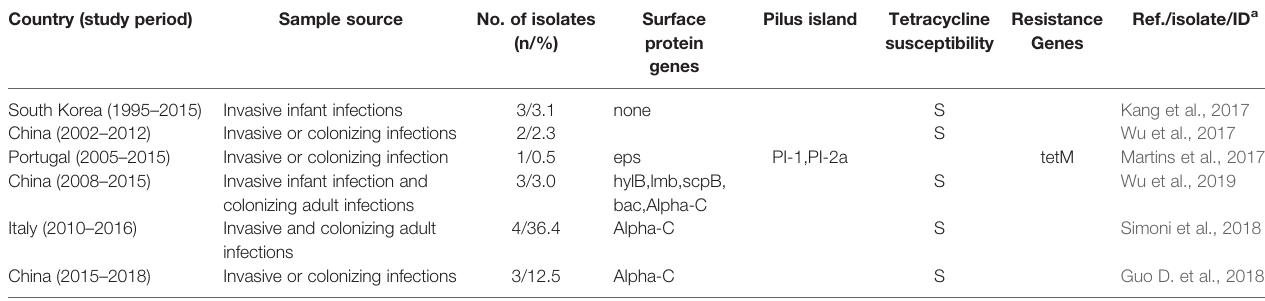
TABLE 4 | Information on the susceptibility to tetracycline of type Ib/ST10 GBS strains obtained through the literature search. Country (study